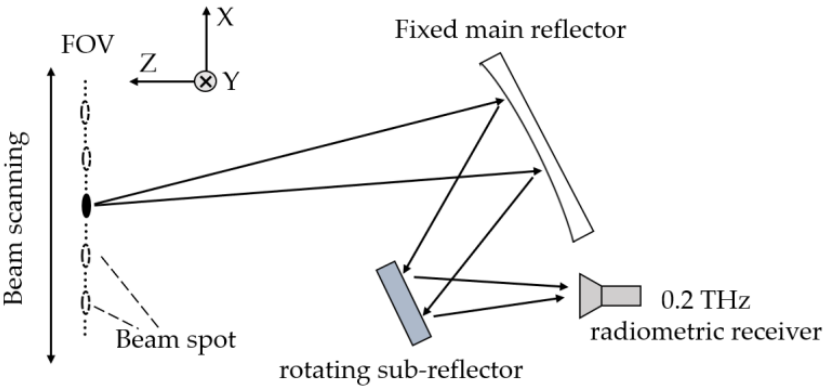
Figure 5. Simple architecture of the imager.